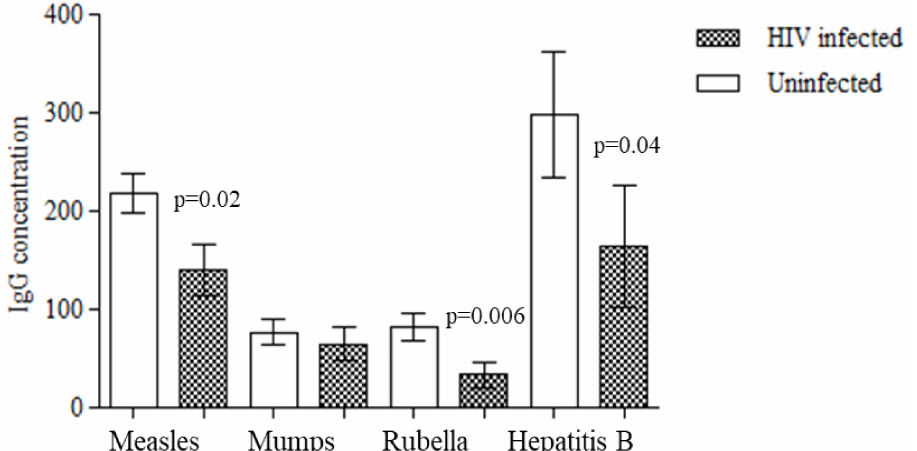
Figure 2. The mean serum concentration of IgG to measles rubella and hepatitis B viruses was significantly lower in children with HIV infection acquired perinatally compared to uninfected controls. No significant difference was observed in mean serum concentration of IgG for mumps between